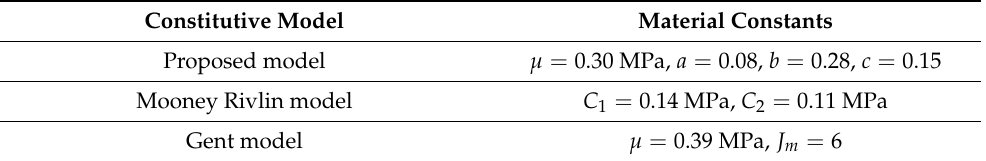
Table 1. Material parameters of proposed (19), Mooney Rivlin (20), and Gent (20) material models for Latex.